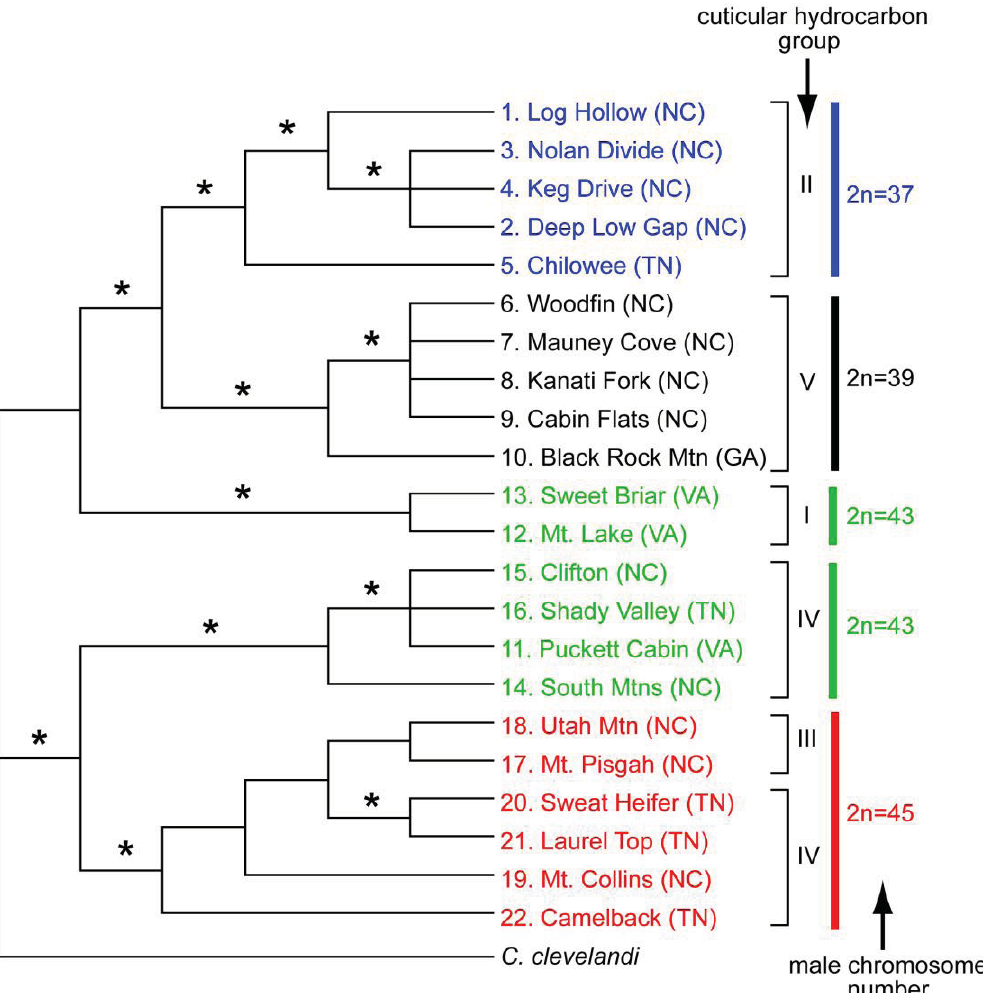
Figure 4. Strict consensus of three MP trees of the Cryptocercus punctulatus species complex from 22 locations derived from the combined datasets of mtDNA and nuclear DNA (re-drawn from the figure shown in Everaerts et al. [11]). Nodes with strong support (more than 90% Bayesian posterior probabilities and MP bootstrap probabilities) are indicated by an asterisk. Each terminal is labeled with the collection location number and name (shown in Figure 2c). Cuticular hydrocarbon group and the male chromosome number are also